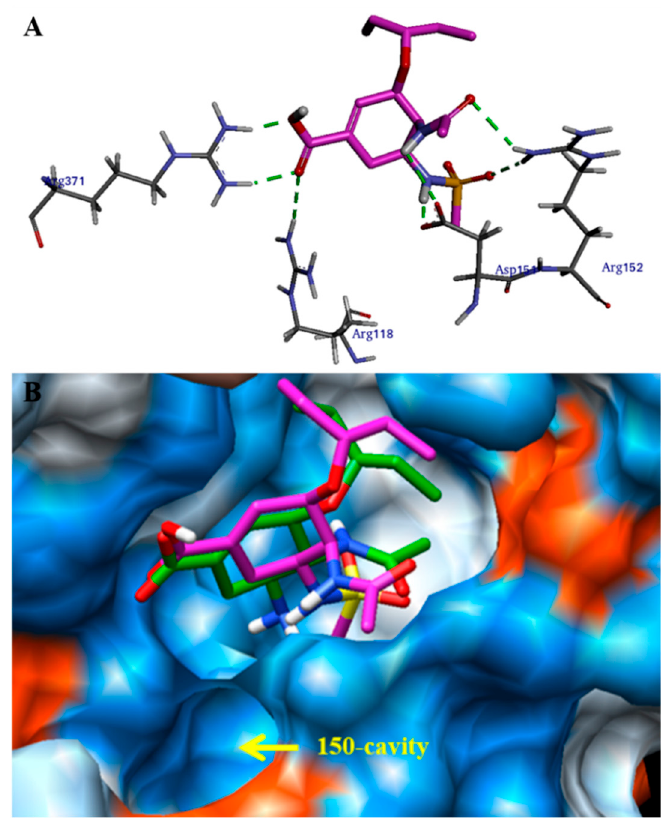
Figure 4. ( A ) The docking modes of compound 4a (purple) with NA from H5N1 (PDB code 2HU4,